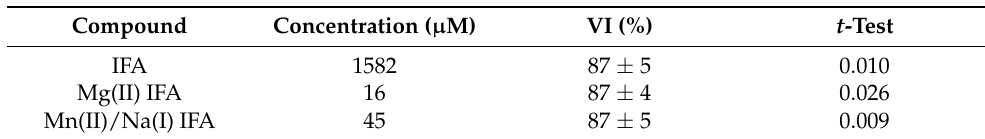
Table 6. Cell viability inhibition in HaCaT cells treated with Mn(II)/Na(I) and Mg(II) complexes of IFA in the highest-obtained concentrations, versus the toxicity of IFA. VI = viability inhibition. The VI is measured versus the non-treated cell culture. All the values differ significantly from the control at the significance level at α = 0.05, as shown by the t -test.